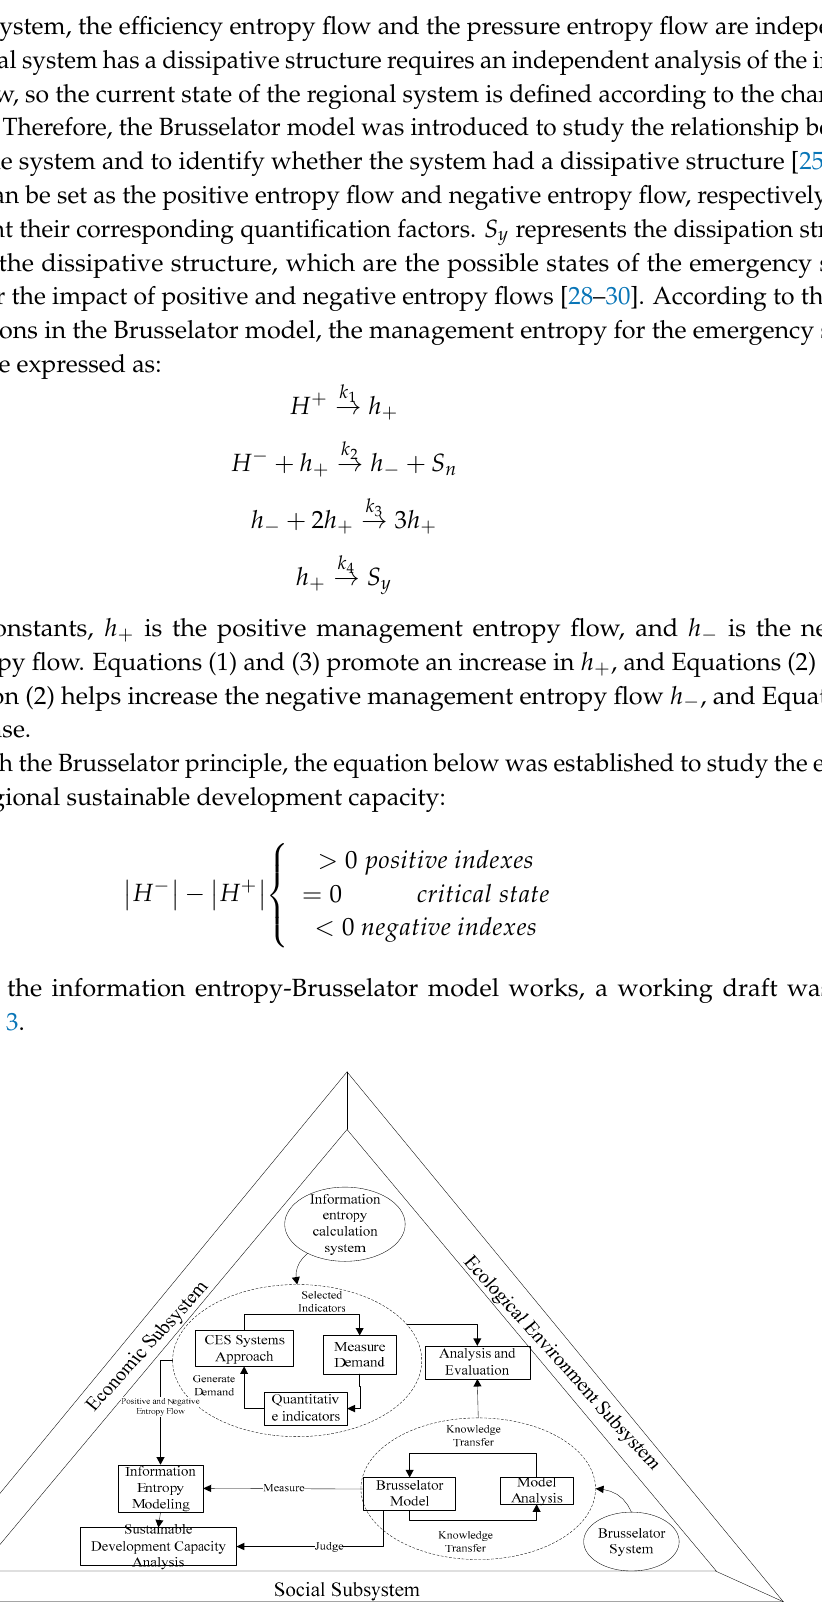
Figure 3. Information entropy-brusselator measurement model.